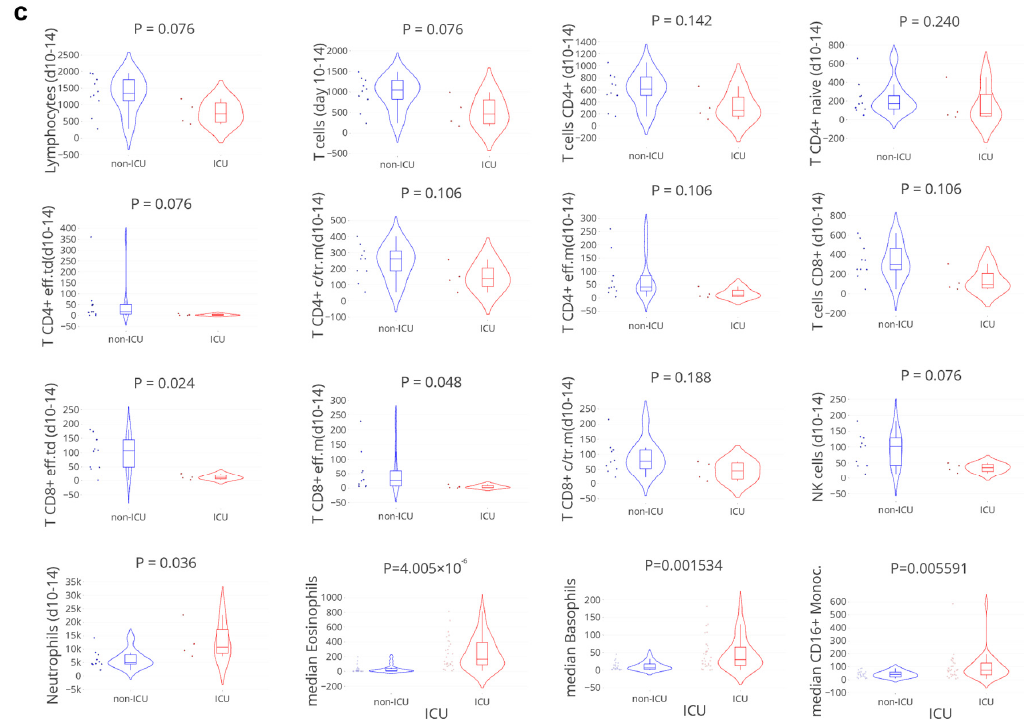
Figure 4. ( a ). Low density of circulating CD4+ T cell compartment in a patient with delayed viral clearance (right). Representative illustration of CD4+ T cell compartment in the peripheral blood samples of a patient with rapid (left: duration of positive PCR—1 day) or delayed viral clearance (right: duration of positive PCR—29 days). CM = central memory; TM = transitional memory; EM = effector memory; TD = effector, terminally differentiated; data analysis performed with Infinicyt software (Cytognos, Salamanca, Spain), each diagram is a representation of automated population separator (APS). One sample for each of the two patients. ( b ). Reduced circulating (naïve) CD4+ T cells, post-GC B cells, and memory B cell count over time corresponds with delayed viral clear- ance . Kinetics of absolute counts of circulating leukocyte subsets (measured as cells/ μ L) in relation to the time to viral clearance, a selection of subsets based on p -values (see Supplementary Figure S2). Groups with rapid: ≤ 21 days (blue lines/dots) and delayed: > 21 days viral clearance (red lines/dots). Lines indicate non-linear group trends. Spline regression with bootstrap confidence in- tervals. ( c ). Reduced CD8+ effector T cell count at day 10–14 corresponds with ICU admission . Mean values at day 10–14 grouped by non-ICU (blue)/ICU (red) patients, and median values per patient. T CD4+ c/tr.m; T cells CD4+ central/transitional memory, T CD4+ eff.m; T cells CD4+ effector